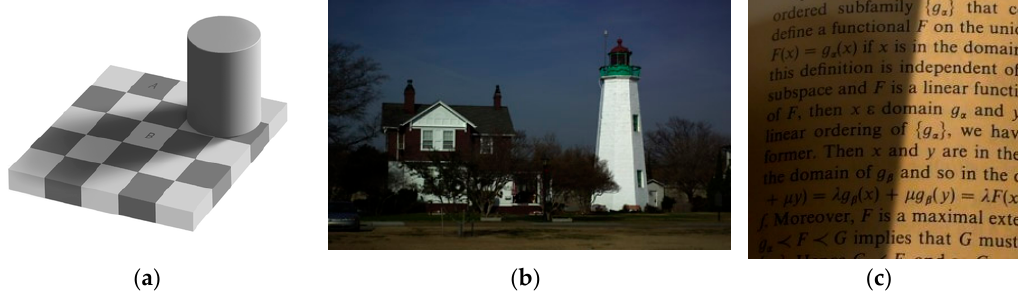
Figure 10. Test images. ( a ) Checkerboard image; ( b ) Tower image; ( c ) Text image.